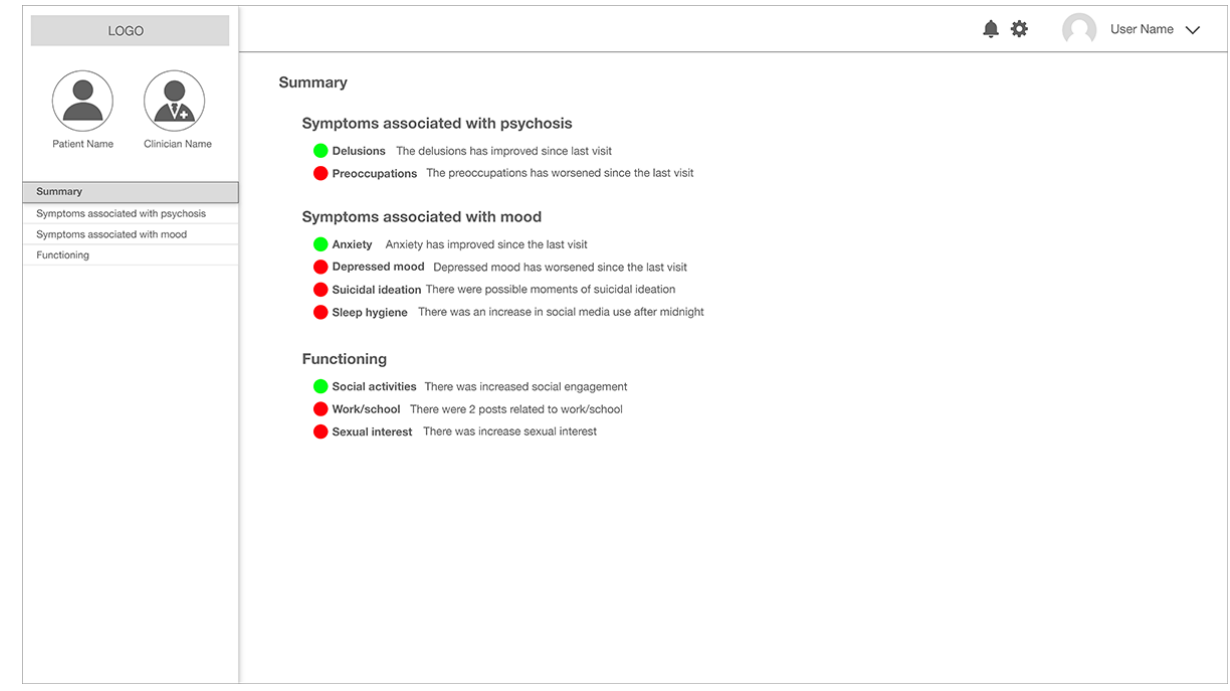
Figure 9. The final (third) version of our prototype: A clinical summary